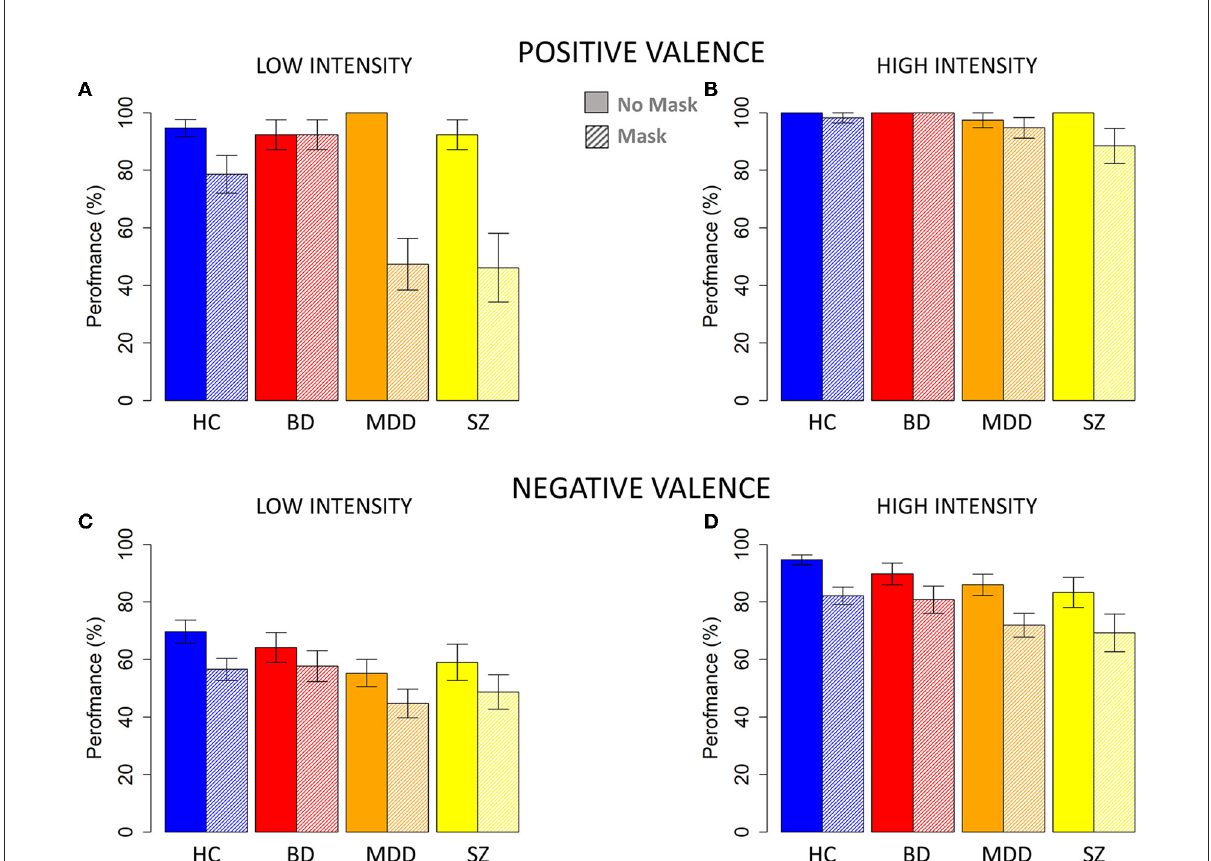
FIGURE3 Percentage of correct responses without and with face masks for each group. (A) Performance for images with low-level positive valence. (B) Performance for images with high-level positive valence. (C) Performance for images with low-level negative valence. (D) Performance for images with high-level negative valence. HC, healthy control; BD, patients with bipolar disorder; MDD, patients with major depressive disorder; SZ, patients with schizophrenia. Filled and shaded color bars represent images without and with face masks, respectively. The standard error of the mean (SEM) is